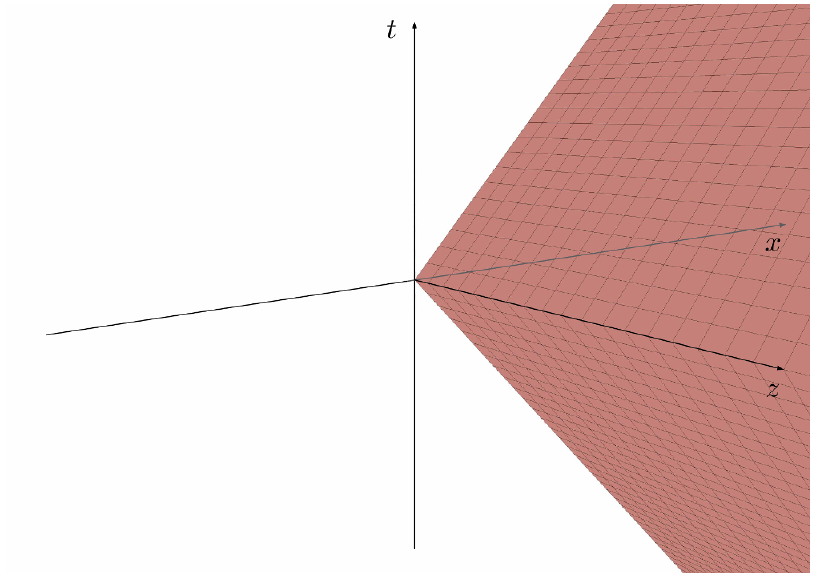
Figure 5 . The planar BTZ black hole, viewed as a patch of Poincar(cid:19)e AdS. The boundary of this patch is the Rindler wedge of the z = 0